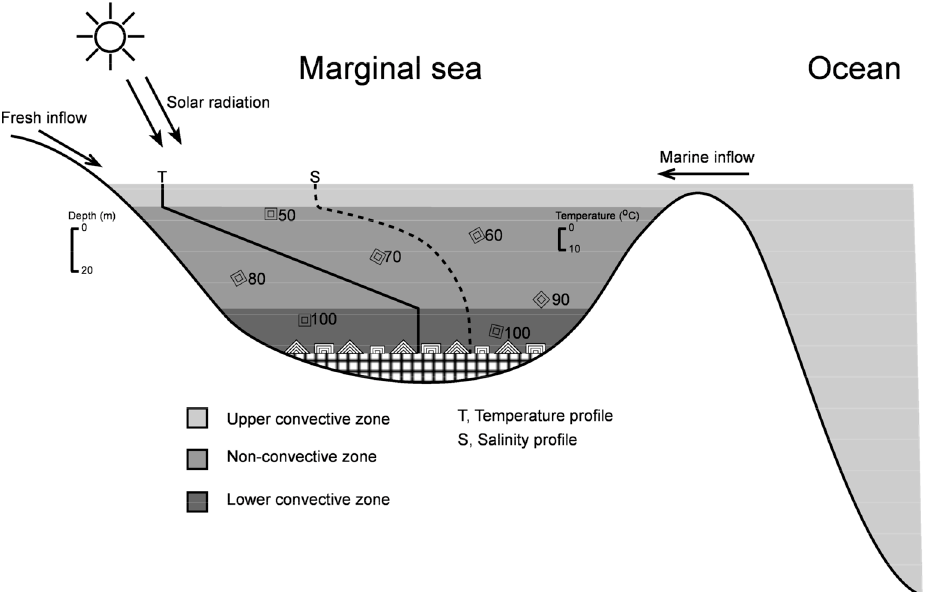
Figure 7. Cartoon illustrating the solar heating hypothesis in a salinity-stratified, marginal sea proposed in this paper to explain the anomalously high brine temperatures documented from dissolution temperatures of daughter crystals in fluid inclusions in Cretaceous halites. Crystals with numbers show nucleation/precipitation temperatures.